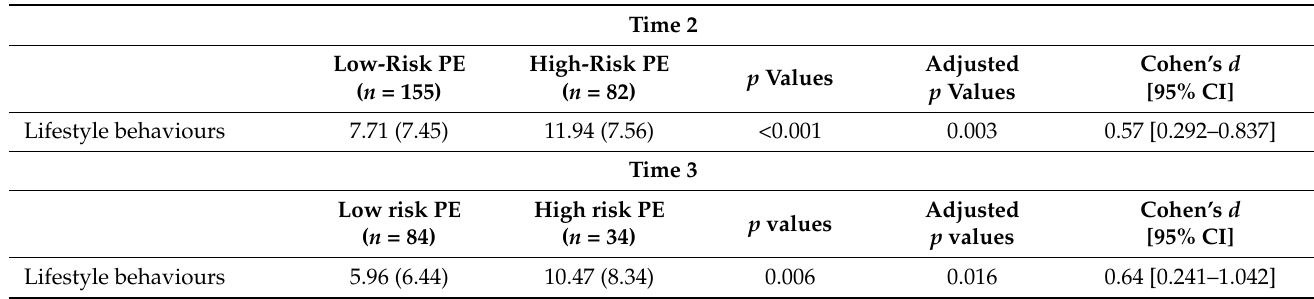
Table 3. Group (low and high PE risk) differences in lifestyle-related behavioural changes after PE screening at times 2 and 3.